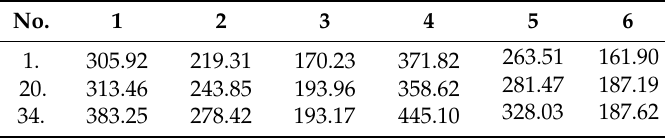
Figure 13. The resulting temperature diagram numerical simulations at the six selected points for 33rd, 33rd, 34th, 35 th , and 36th point of the experimental plan [22]. 34th, 35 th , and 36th point of the experimental plan [22]. Table 3. Point Tracking (Temperature ◦ Table 3. Point Tracking (Temperature °C). Table 3. Point Tracking (Temperature °C).